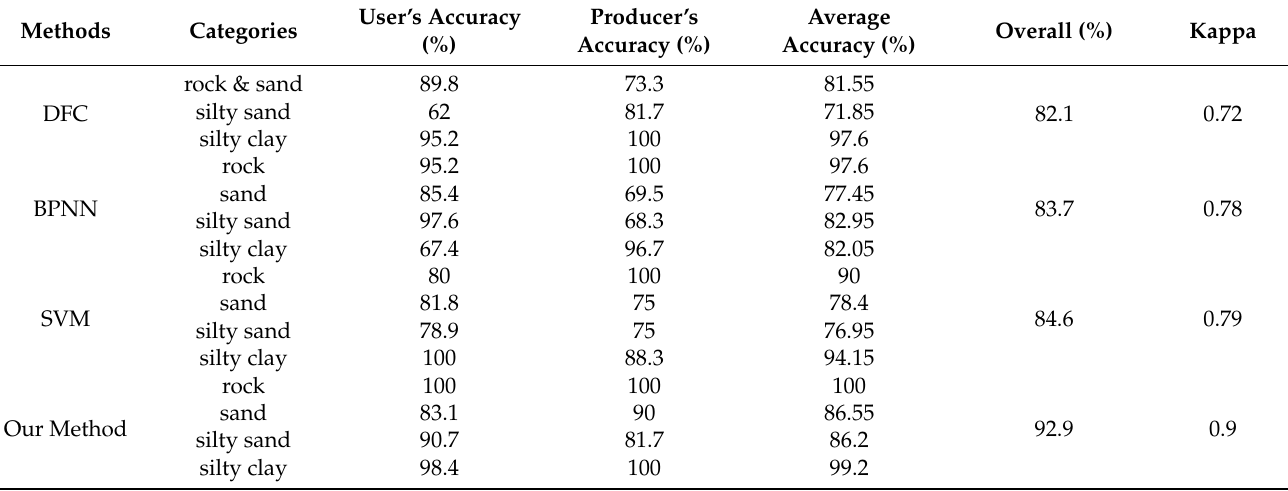
Table 6. Classification accuracy of different classifiers in